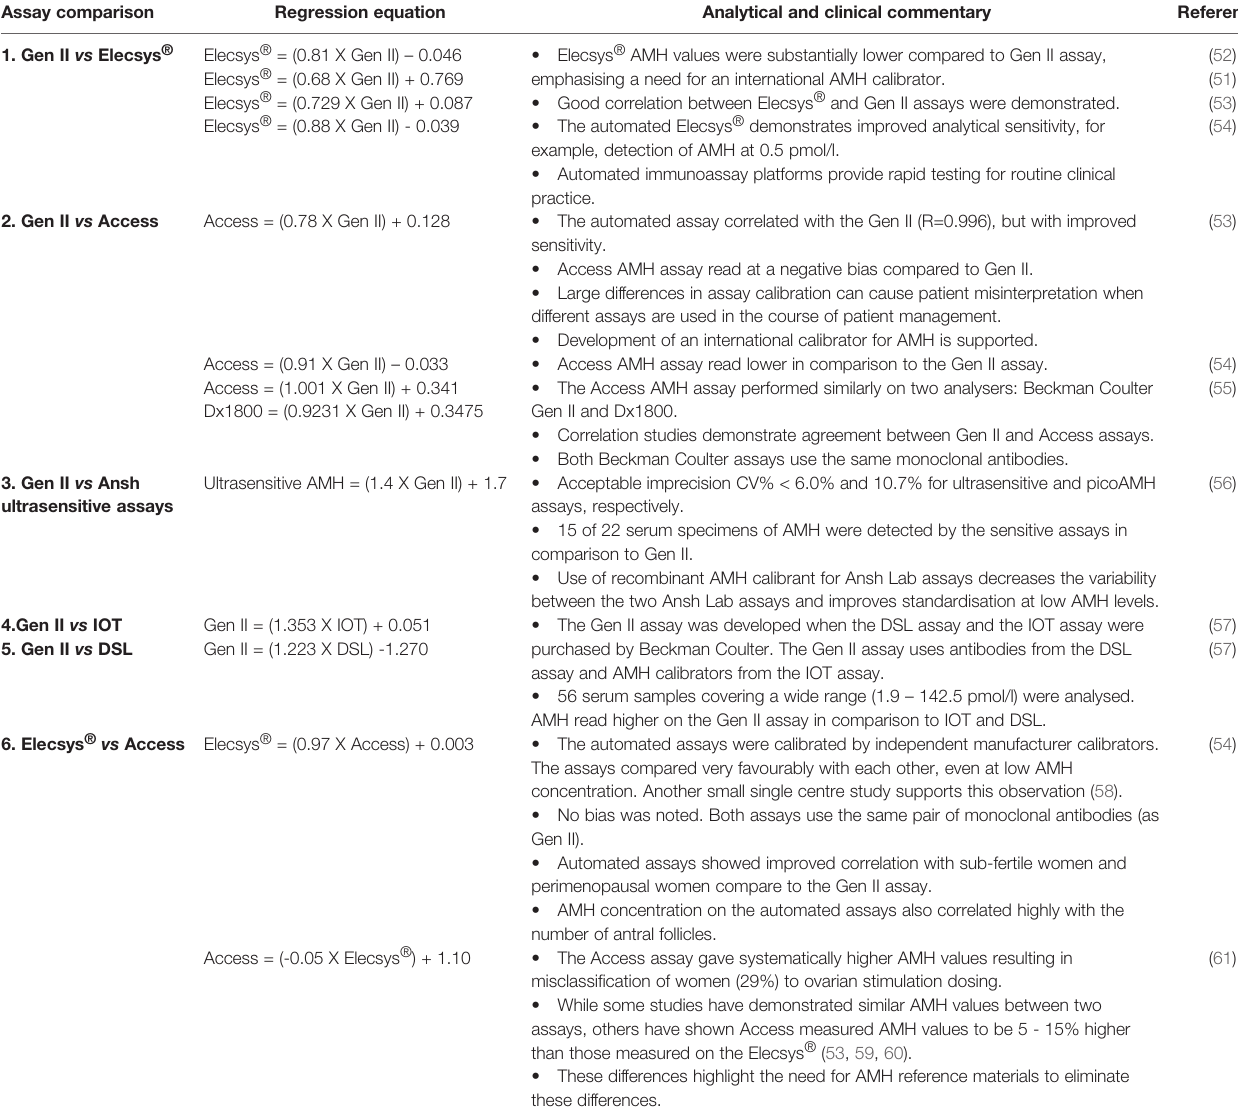
TABLE 2 | Method comparison evaluations between commercial AMH